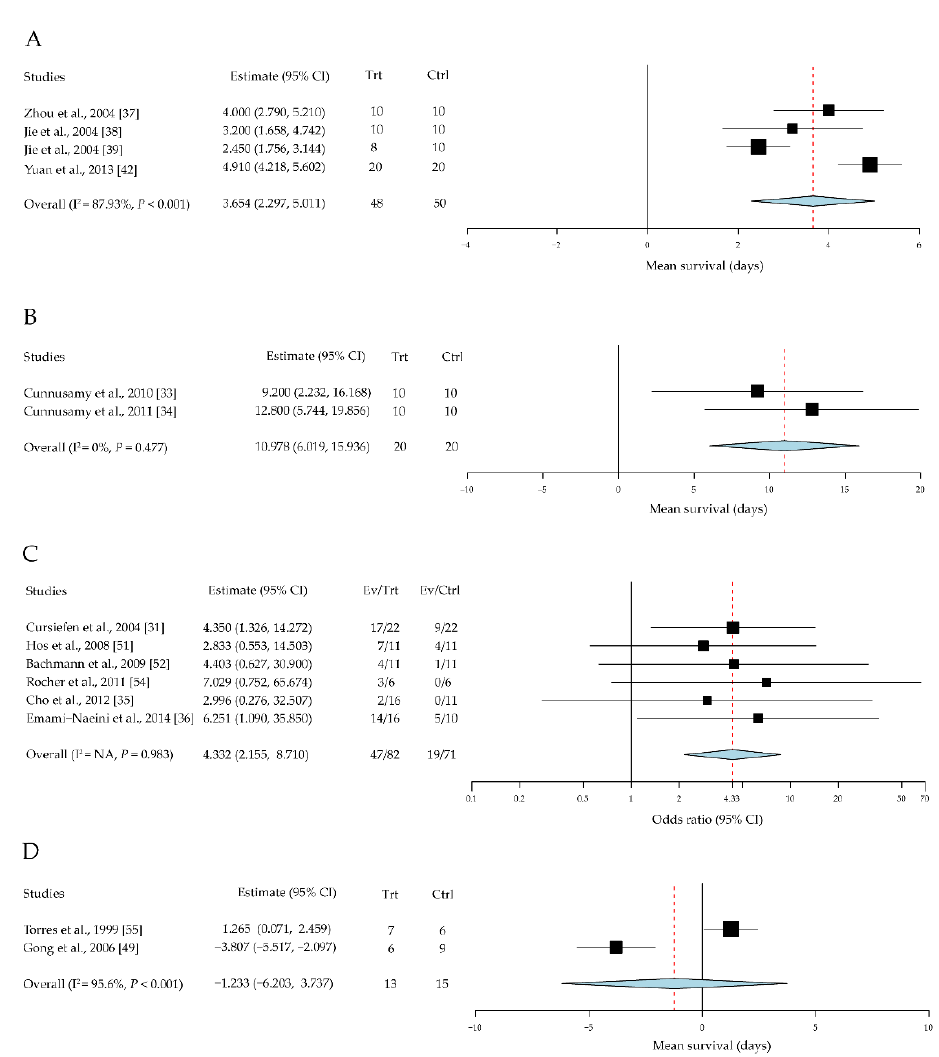
Figure 3 . Effects of cytokines in immunotherapies for corneal allografts. ( A ) IL-1RA promotes allograft survival. ( B ) Anti-IL-17 antibody increased allograft rejection. ( C ) Anti-VEGF improves allograft survival rate. ( D ) Local administration of IL-10 did not improve allograft survival. CI, confidence intervals; EV, event; Trt, treatment; Ctrl, control.